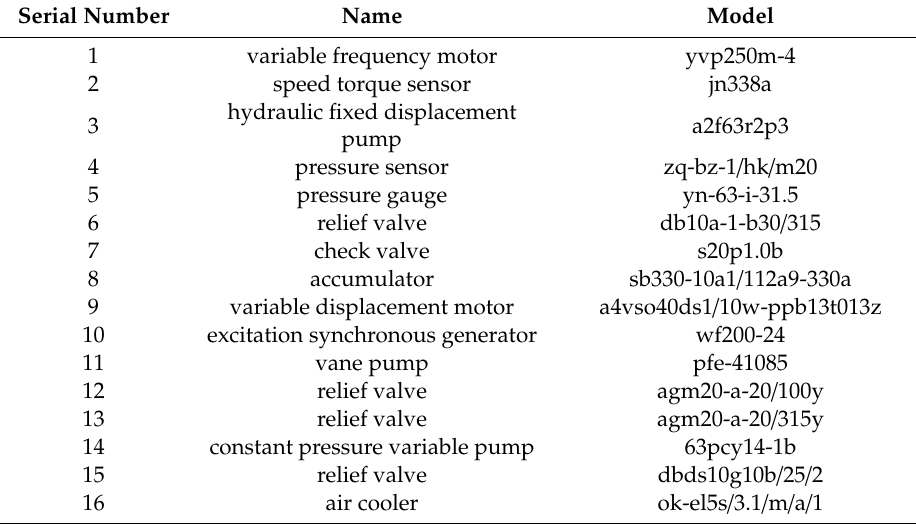
Figure 9. The structure diagram of 30 kVA semi-physical simulation platform. Table 3. 24 kW semi physical simulation experiment platform components.